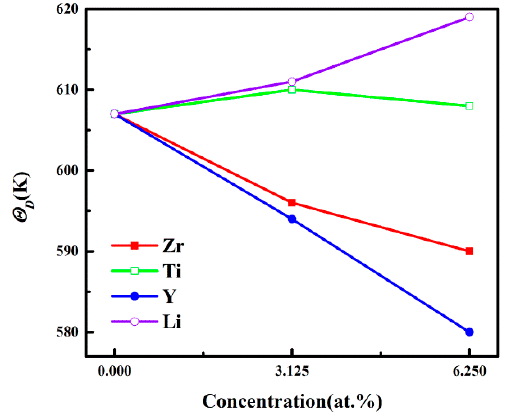
Figure 5. The Θ D values of L1 2 -Al 3 Sc doped with element M (M = Zr, Ti, Y, and Li) as a function of the doping concentration.